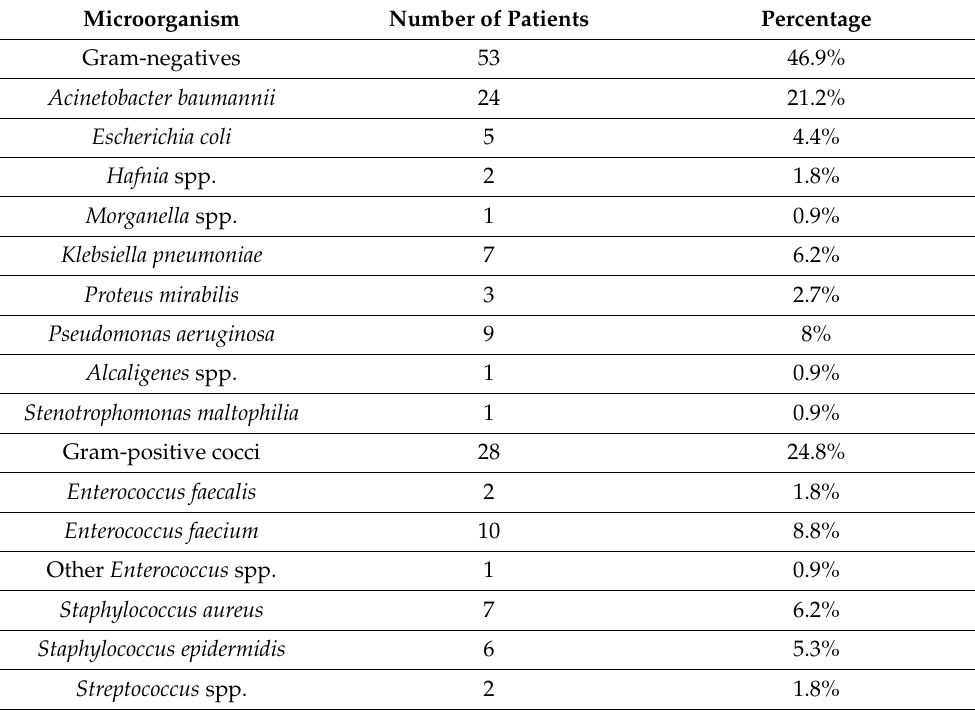
Table 2. Microorganism distribution in patients with hospital-acquired